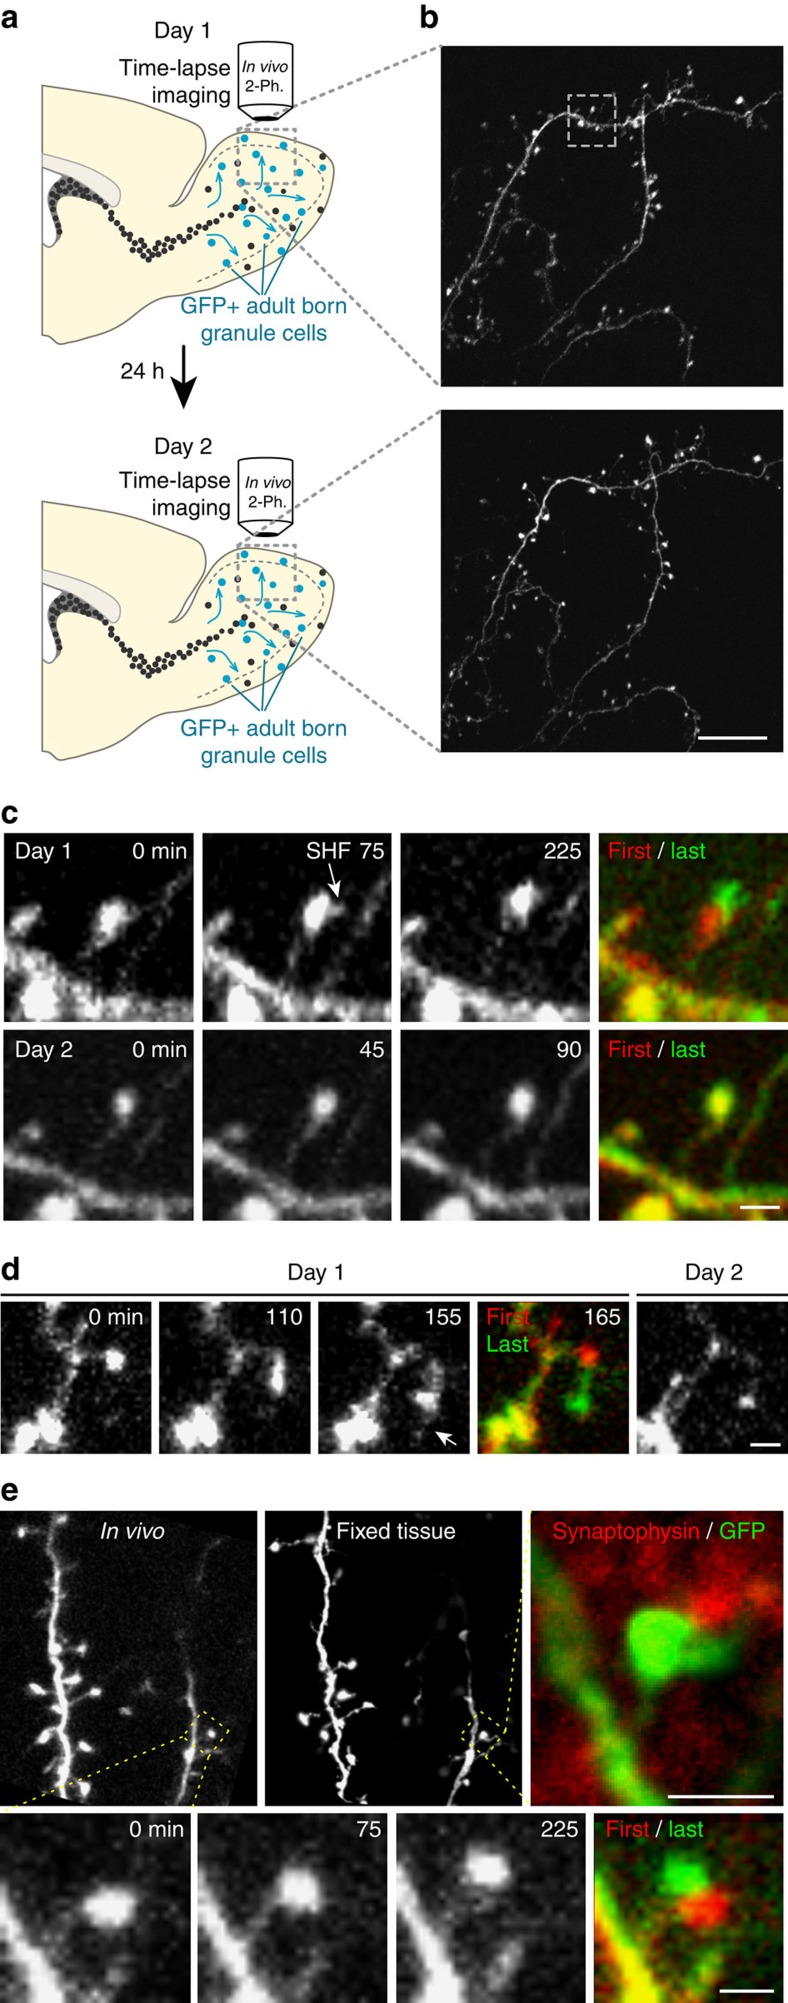
Relocated spines are stabilized in the OB network and are part of the dendro-dendritic synapses.(a) Experimental procedure for chronic in vivo two-photon imaging. (b) Example of GC dendrite images acquired on 2 consecutive days. (c) Higher magnification of the boxed area in b. Time-lapse two-photon imaging of relocating spine during the first imaging day (upper panel). Note that the same spine is stabilized at the relocated position and that no displacement is observed during the second imaging day. The first and last z-stacks have been false-coloured in red and green to compare the first and last images of the time-lapse sequence, respectively. (d) Another example of relocating spine. (e) In vivo images showing the spine relocation of an adult-born GC (lower panels). At the end of the in vivo imaging, the animal was perfused, and OB sections were prepared for anti-synaptophysin immunohistochemistry. Confocal image showing the dendrite of the imaged GC (upper middle panel) and the anti-synaptophysin labelling (upper right panel). Note that spine relocating in vivo is directly opposed to synaptophysin puncta. Scale bars: 20 μm for b 2 μm for c,d; 5 μm for e centre panel and 2 μm for e right panels.